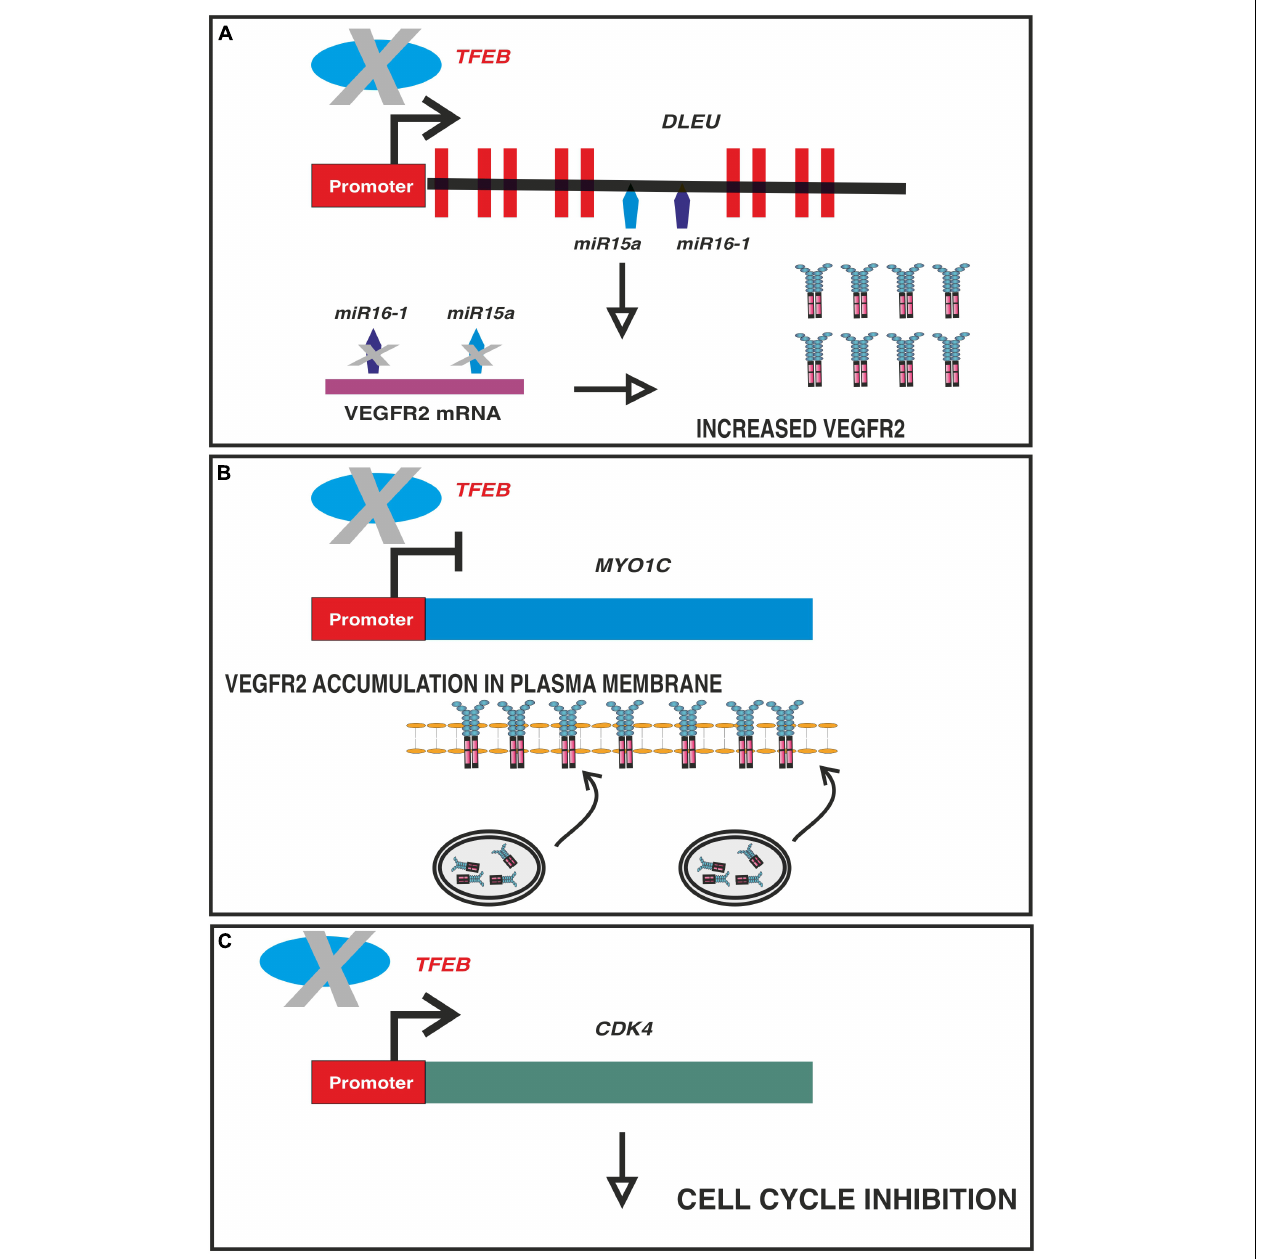
FIGURE 3 | Multiple effects of TFEB deletion on ECs. In vascular ECs, TFEB directly binds and regulate the promoters of: (A) DLEU2 , which encodes miR-15a/16-1 cluster (A,B) MYO1C and (C) CDK4 . Panel (A) : in absence of TFEB the post-transcriptional regulation of VEGFR2 mediated by miR-15a-5p and miR-16-5p is impaired leading to an increased stabilization of the transcript. Panel (B) : TFEB is a repressor of MYO1C , an unconventional myosin involved in VEGFR2 exocytosis. In absence of TFEB, the expression of this gene is increased and more VEGFR2 is available and transported to plasma membrane through Rab4 + exocytic vesicles. As a consequence the receptor recycling is impaired with a reduced efficiency of signaling machinery. Panel (C) : TFEB transactivates CDK4 and the consequence of its deletion is the cell cycle in G1